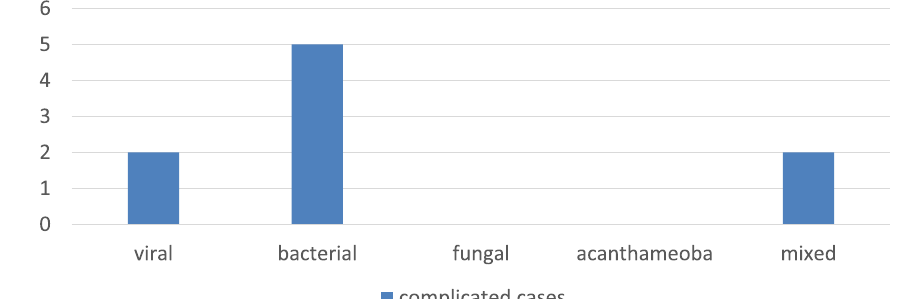
Fig. 8 The distribution of complicated cases among the 5 MK